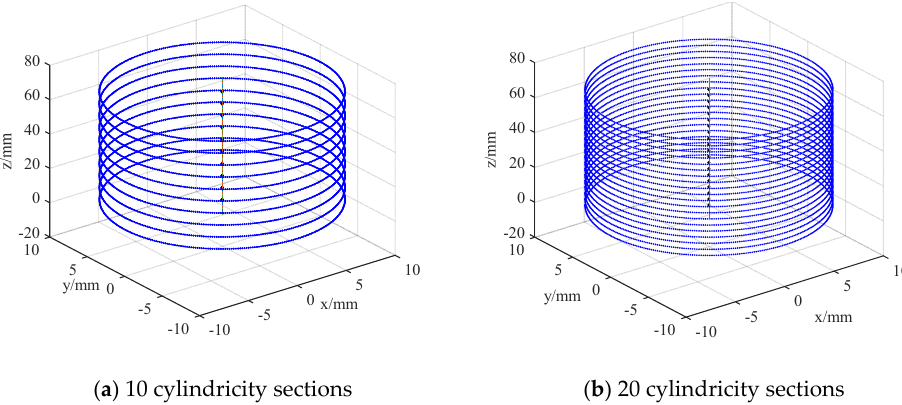
Figure 20. Graph fitting of workpiece axis and measured points.